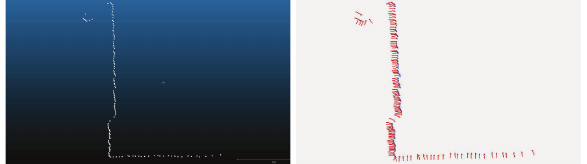
Figure 4: An illustration of the normal estimation by RDPCA:(Left) the partial points of a laser scan; (Right) the corresponding orientations of the point normals marked in red lines, which were computed by